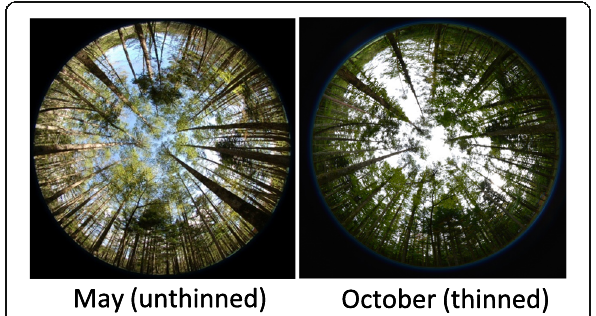
Fig. 3 Hemispherical photographs of the study area